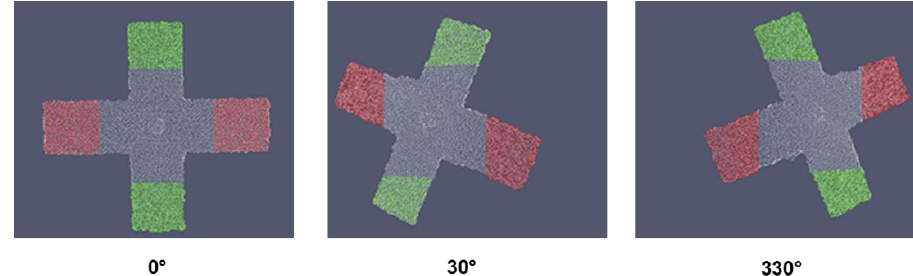
Figure 6. The cross-shaped object point clouds at three angular positions of the camera: the upper and lower sections are highlighted with green color, the left and right sections are highlighted with red color.